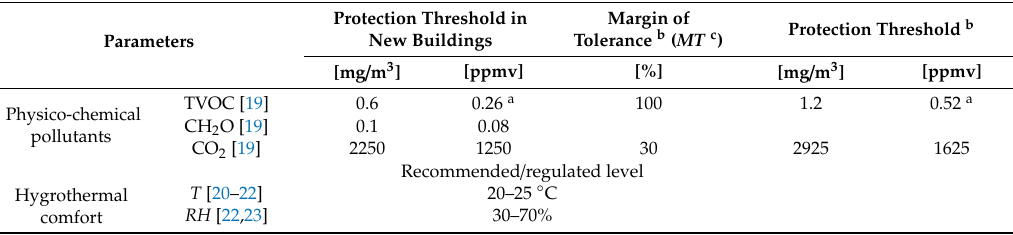
Table 5. Parameters measured and reference